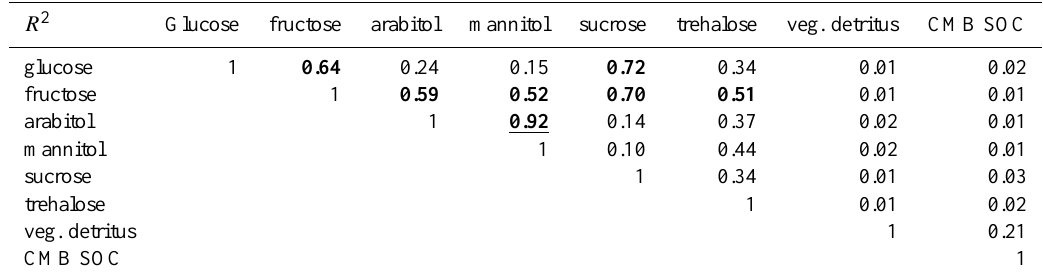
Table 2. Pearson correlation coefficients ( R 2 , N = 26) between biogenic markers, vegetative detritus OC and CMB SOC. 0 . 5 < R 2 < 0 . 8 and R 2 > 0 . 8 are displayed, respectively, in bold character and in bold character and underlined. R 2